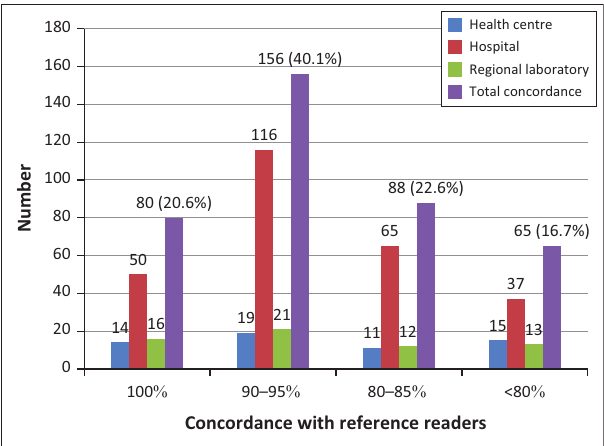
FIGURE 1: Concordance of tuberculosis external quality assessment rechecking laboratory microscopists with reference readers for detecting tuberculosis bacilli, Ethiopia ( N =389), April–July, 2015